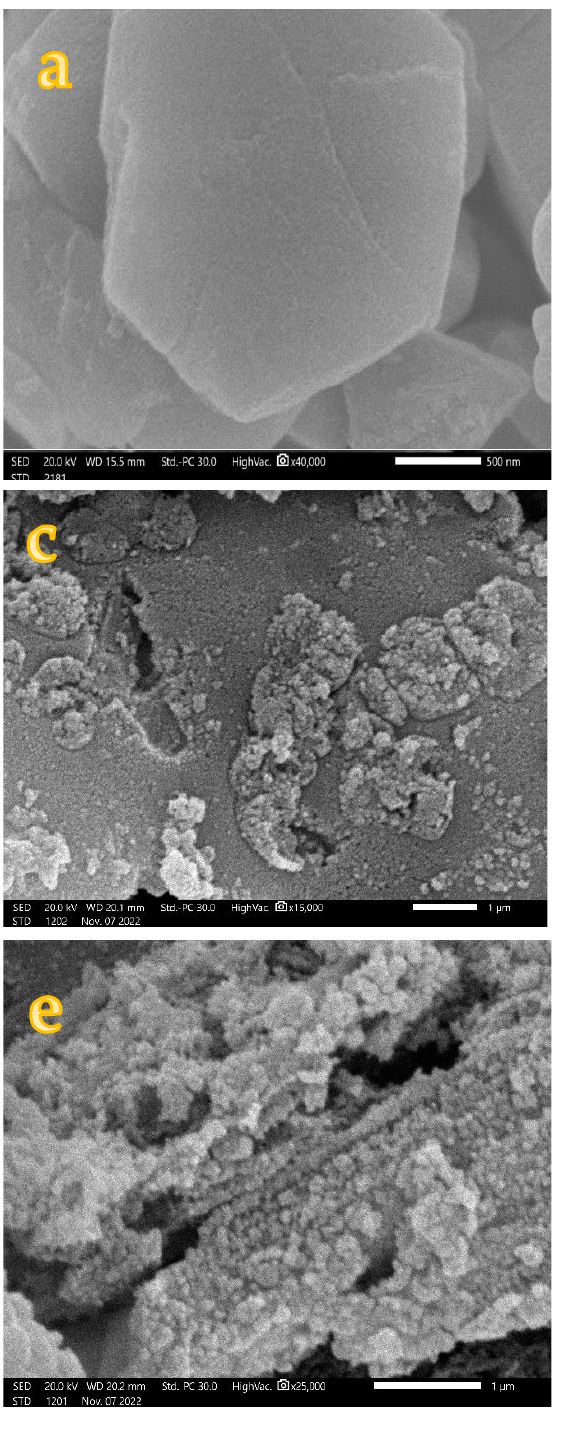
Figure 7. SEM images of ( a ) pure AC, ( b ) 10NFAC, ( c ) 25NFAC, ( d ) 45NFAC, and ( e ) 65 NFAC.